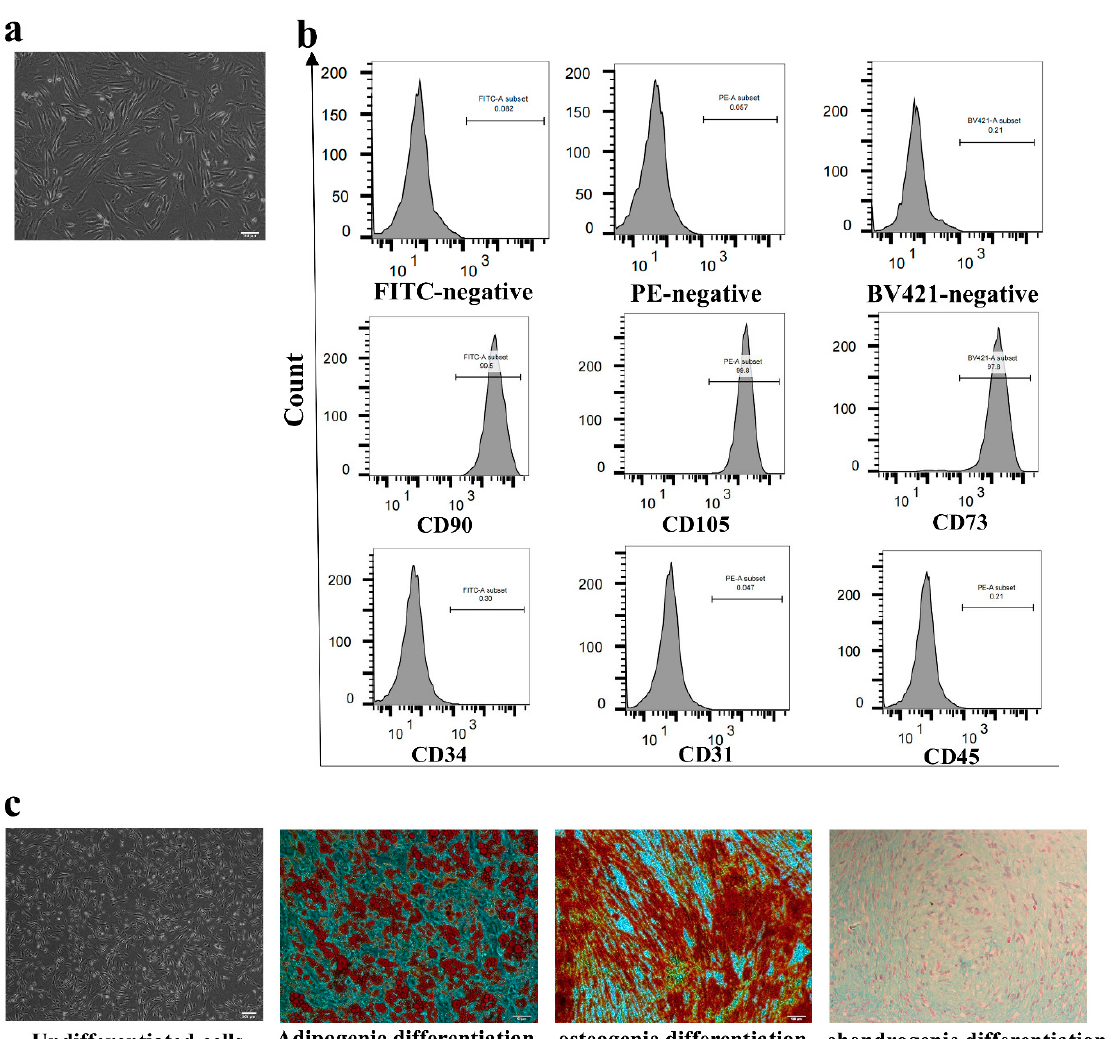
Figure 1. Characterization of human adipose-derived mesenchymal stem cells (AD-MSCs). ( a ) Pho- tomicrograph of adherent AD-MSCs with spindle shapes on a cell culture dish. Scale bar = 100 µ m. ( b ) Flow cytometric characterization of AD-MSCs. CD105, CD90, and CD73 were positive, while CD34, CD31, and CD45 were negatively expressed. ( c ) Multiple differentiation potential of AD-MSCs. The AD-MSCs were differentiated into matured adipocytes, osteocytes, and chondrocytes after incubation with adipogenic, osteogenic, or chondrogenic differentiation mediums at the times indicated, respectively. Adipocytes, osteocytes, and cartilage differentiated from AD-MSCs were determined through staining with Oil Red O, Alizarin Red and Alcian Blue, respectively. Scale bar = 200 μ m.